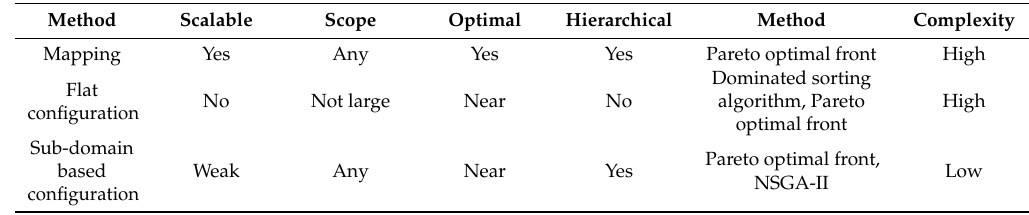
Table 3. Overview of QoS-parameter configuration in